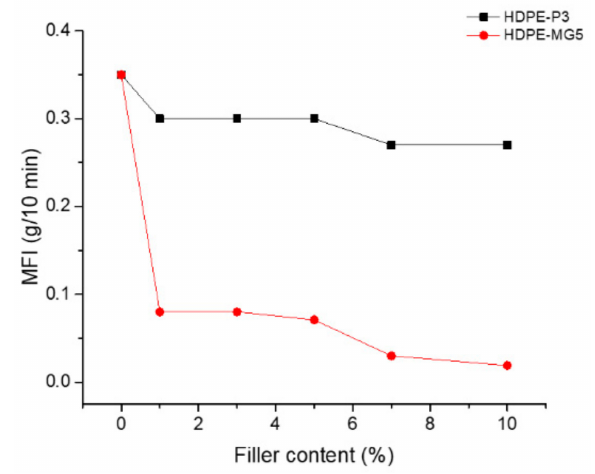
Figure 7. E ff ect of filler loading on the MFI of P3 and MG5 HDPE